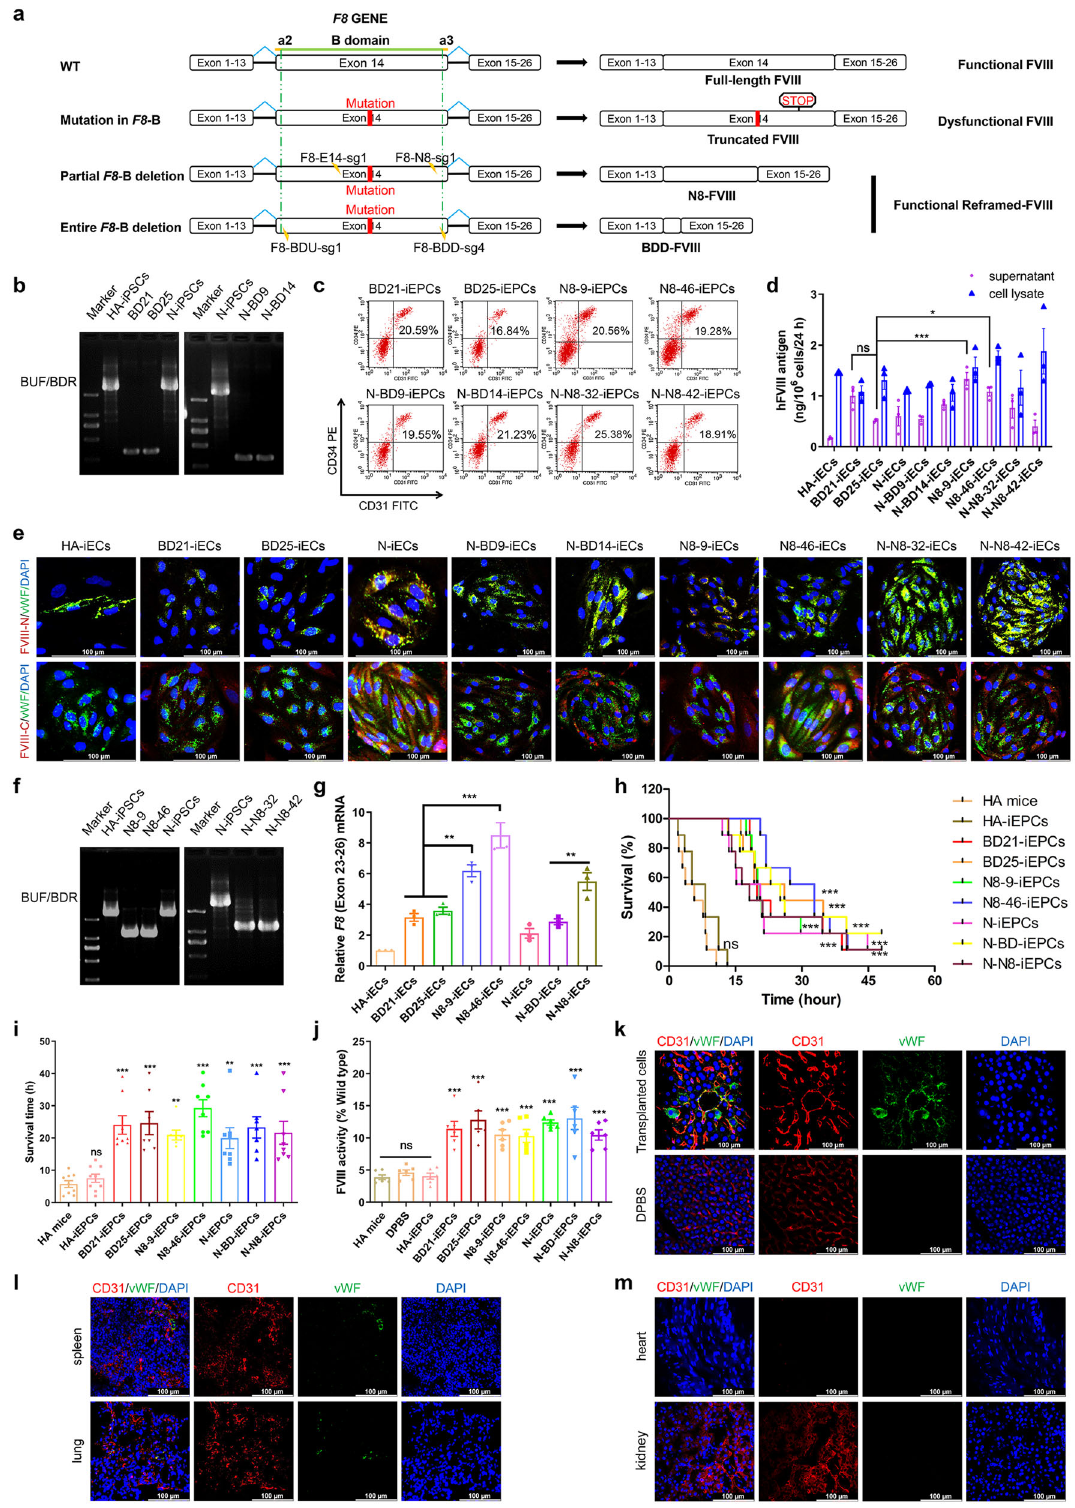
mice (5.73 h) (Fig. 1h, i). Notably, three of the 18 HA mice transplanted with BD-iEPCs and 3 of the 18 HA mice with N8-iEPCs were alive 48 h after tail-clip challenge (the experiment endpoint). Furthermore, we observed higher plasma FVIII activities in HA mice transplanted with BD-iEPCs and N8-iEPCs (12.79% and